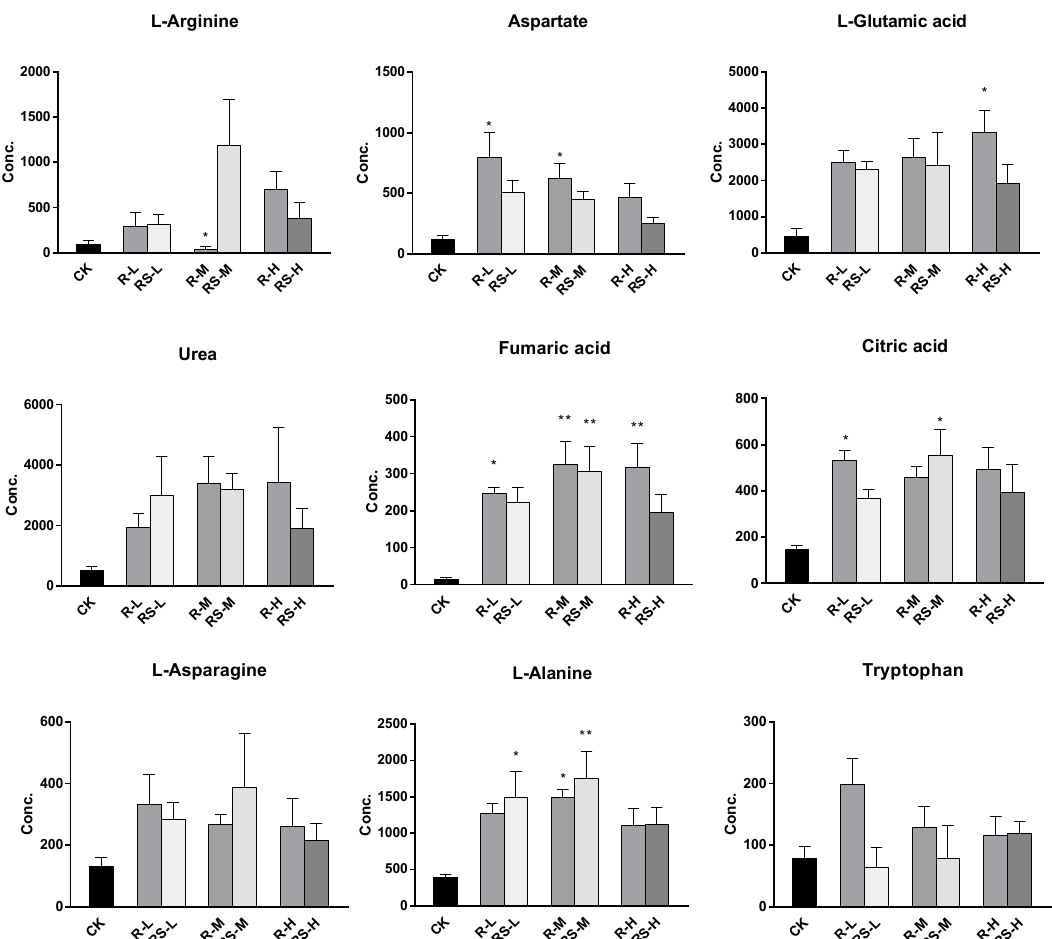
Figure 4. The concentration shifts of some metabolites after exposure to metalaxyl and metalaxyl-M. RS-L: 0.5 mg/kg Metalaxyl, R-L: 0.5 mg/kg Metalaxyl-M. RS-M: 5.0 mg/kg Metalaxyl, R-M: 5.0 mg/kg Metalaxyl-M. RS-H: 50 mg/kg Metalaxyl, R-H: 50 mg/kg Metalaxyl-M.